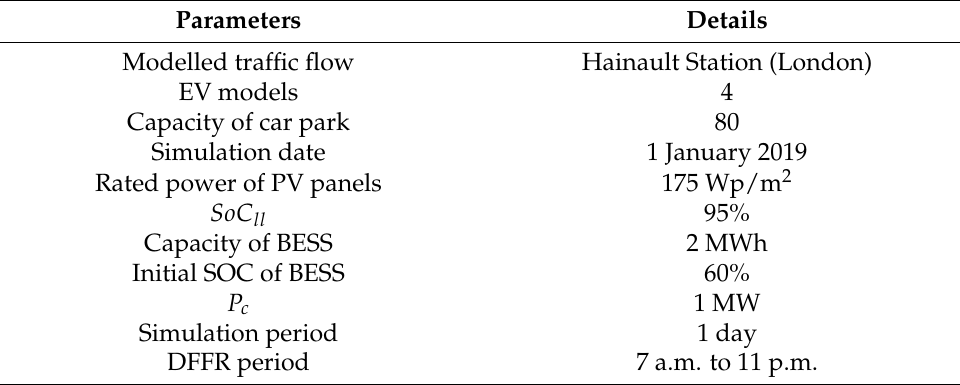
Table 2. The main parameters of the simulation.